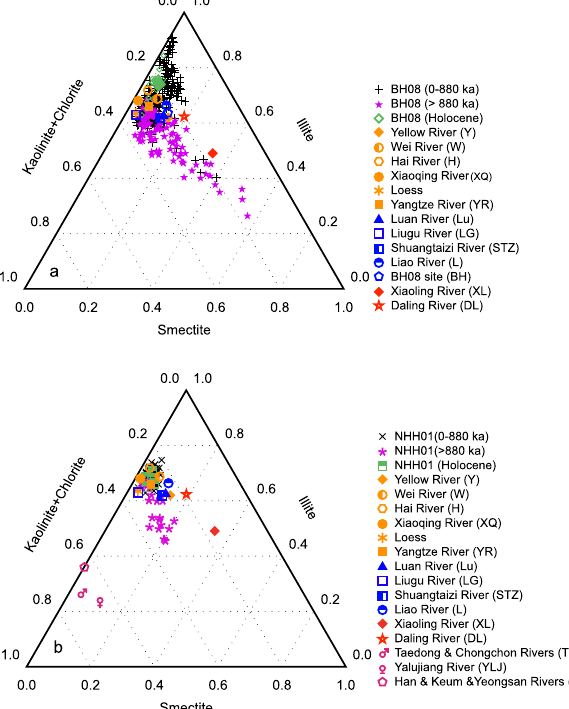
Figure 4. Ternary diagram of illite, kaolinite + chlorite and smectite for cores BH08 and NHH01 dividing at ~880 ka and comparison with potential provenance data. ( a ) Core BH08. ( b ) Core NHH01. The Holocene deposits for cores BH08 and NHH01 were determined by the AMS 14 C results 16, 17 . Also shown are these clay minerals in modern river sediments 30, 69–72 , surface sediments 32 around the BH08 site and loess samples 28 for